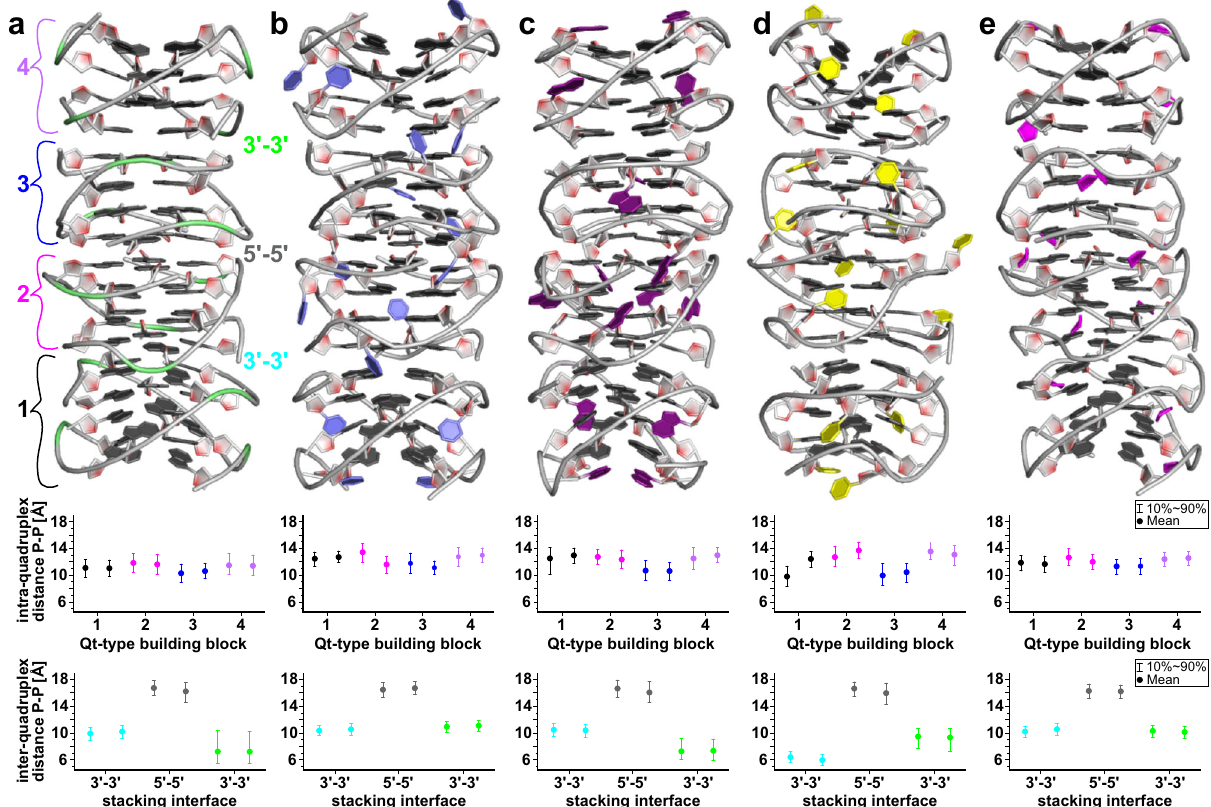
Fig. 6 Hydrophobicity of loop residues and their stacking ability might explain differences in lengths of G-wires. Q4t structures formed by a d(G 2 liG 4 liG 2 ), b d(G 2 TG 4 TG 2 ), c d(G 2 AG 4 AG 2 ), d d(G 2 CG 4 CG 2 ), and e d(G 2 abG 4 abG 2 ). Plots in a – e show mean value (490 measurements for each groove) with corresponding dispersion presented with error bars, for each set of groove distance measurements. We used different colors for data in